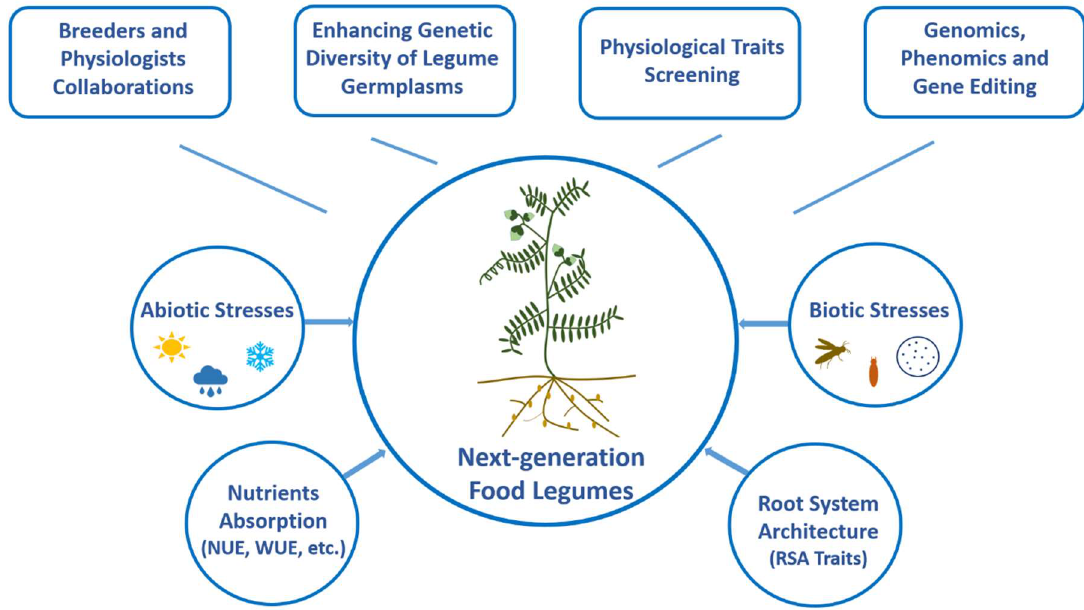
Figure 1. A conceptual framework to design next-generation food legumes. Climate-resilient, nutrient physiologists leveraging the genomics, phenomics, and gene editing advancements.